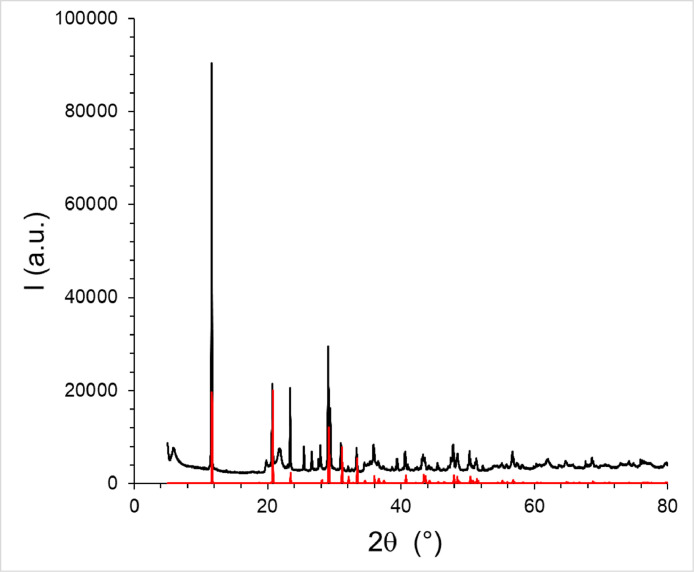
XRD pattern of France GE powder (black) and calculated XRD pattern of CaSO4,2H2O from the CIF file [2].